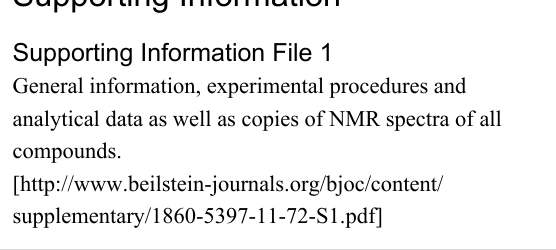
When comparing the two O -sulfated amides 32 and 34 a multi- valency effect is not evident and a sound structure–activity discussion is not feasible as the two compounds have different end groups and different flexibilities. A series of related com- pounds is required to have a better understanding of struc- ture–property relationships and the influence of